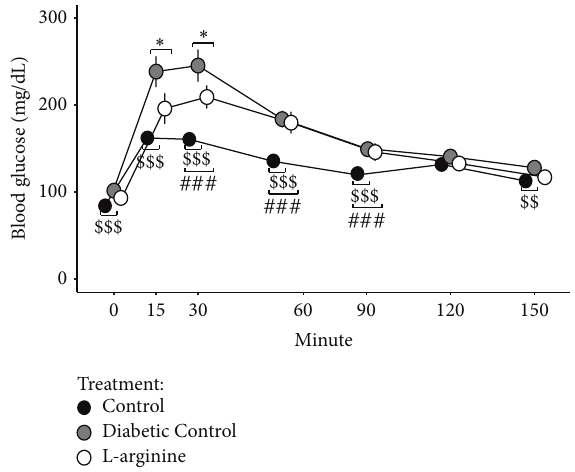
Figure 7: Effect of the high fructose diet alone and high fructose plus L-arginine diet on changes in glucose levels over 150 min in response to a glucose-tolerance test. Control versus Diabetic Control: $$ 𝑃 < 0.01 and $$$ 𝑃 < 0.001 ; Control versus L-arginine: ### 𝑃 < 0.001 ; Diabetic Control versus L-arginine: ∗ 𝑃 < 0.05 .